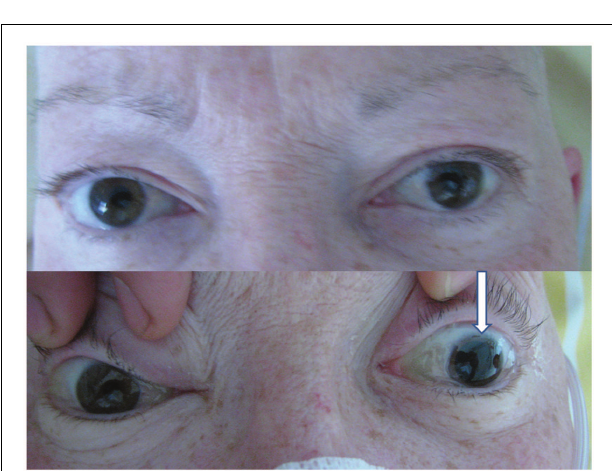
FIGURE 2 | Equal size pupils without blepharoptosis (top) in the interval between attacks of left-sided blepharoptosis, and maximally enlarged pupil during an attack (bottom, arrow) (with written permission of the patient)